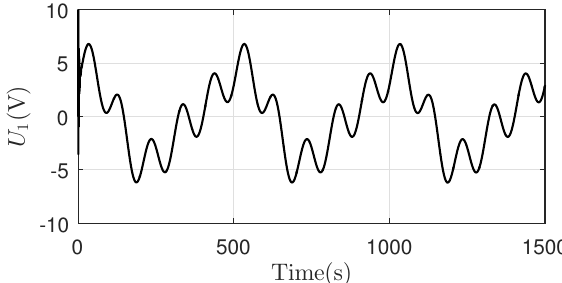
Figure 20. Control input U 1 in floating motion with a variable velocity and constant pitch angle